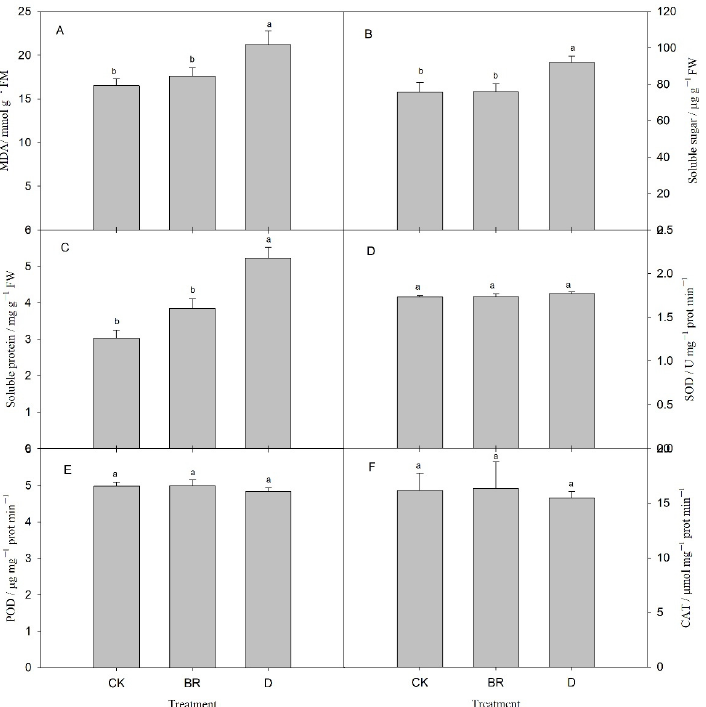
Figure 2. Physiological characteristics of Rhododendron delavayi under control (CK), 24-epibrassionlide (BR), and drought (D) conditions. Data are the means ± SE ( n = 4). Different lowercase letters indicate a significant difference at the 5% level; ( A ) leaf malondialdehyde (MDA) content; ( B ) soluble sugar content; ( C ) soluble protein content; ( D ) superoxide dismutase (SOD) activity; ( E ) peroxidase (POD) activity; ( F ) catalase (CAT) activity.